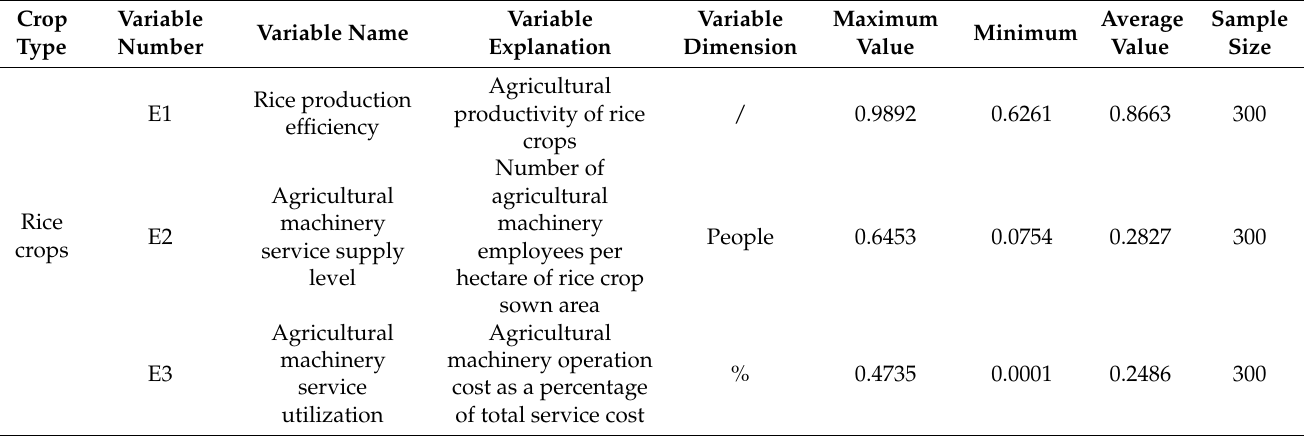
In Formula (15), Landrw represents the wheat planting scale. The specific variables are shown in Table 3. Table 3. Production efficiency model data